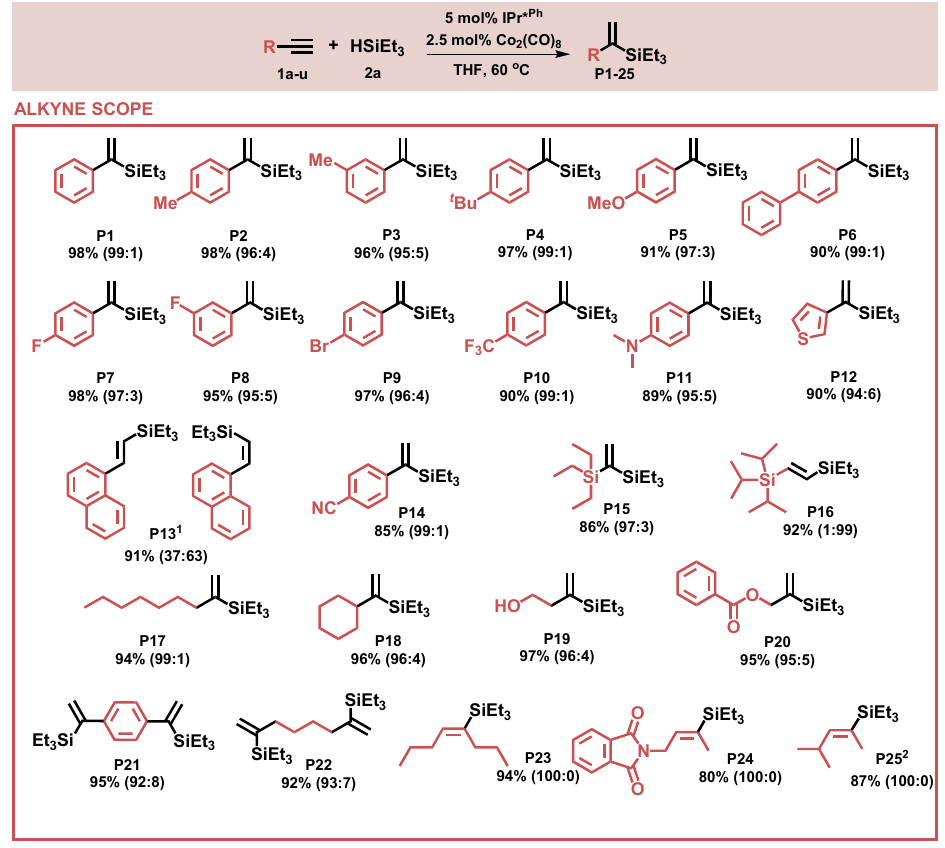
Figure 2. Substrate scope—alkynes. Reaction conditions: argon, THF, 60 °C, 5 h, [ 1a-u ]:[ 2a ] = 1:1, [IPr* Ph ] = 5 mol%, [Co] = 2.5 mol%; isolated yields are given under the product structure.